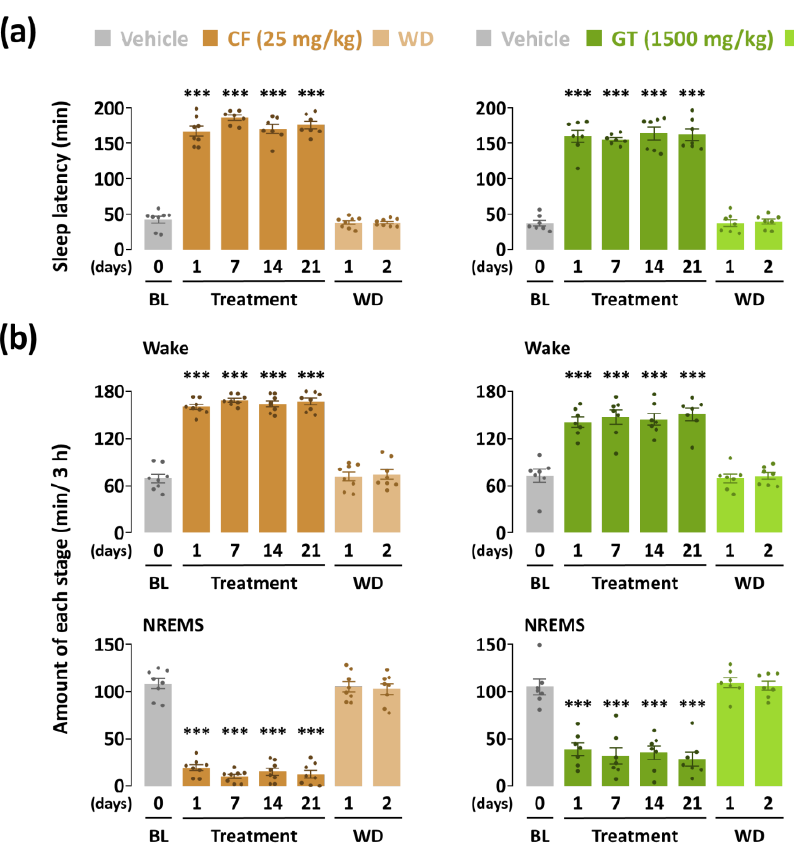
Figure 2. Effects of chronic administration of caffeine (25 mg/kg) and GT (1500 mg/kg) on ( a ) sleep latency and ( b ) amount of wakefulness and NREMS stages during the 3 h after administration. Grey bars illustrate the baseline day (vehicle). Brown and green bars illustrate caffeine and GT treatments, respectively. Light brown and green bars illustrate the withdrawal (WD) days after caffeine and GT treatments, respectively. Every column denotes the mean ± SEM ( n = 7 – 8). *** p < 0.001 indicates significant differences compared to the vehicle (Dunnett’s test). BL, baseline; CF, caffeine; GT, green tea ethanol extract; NREMS, non-rapid-eye-movement sleep; Wake, wakefulness; SEM, standard error of the mean.